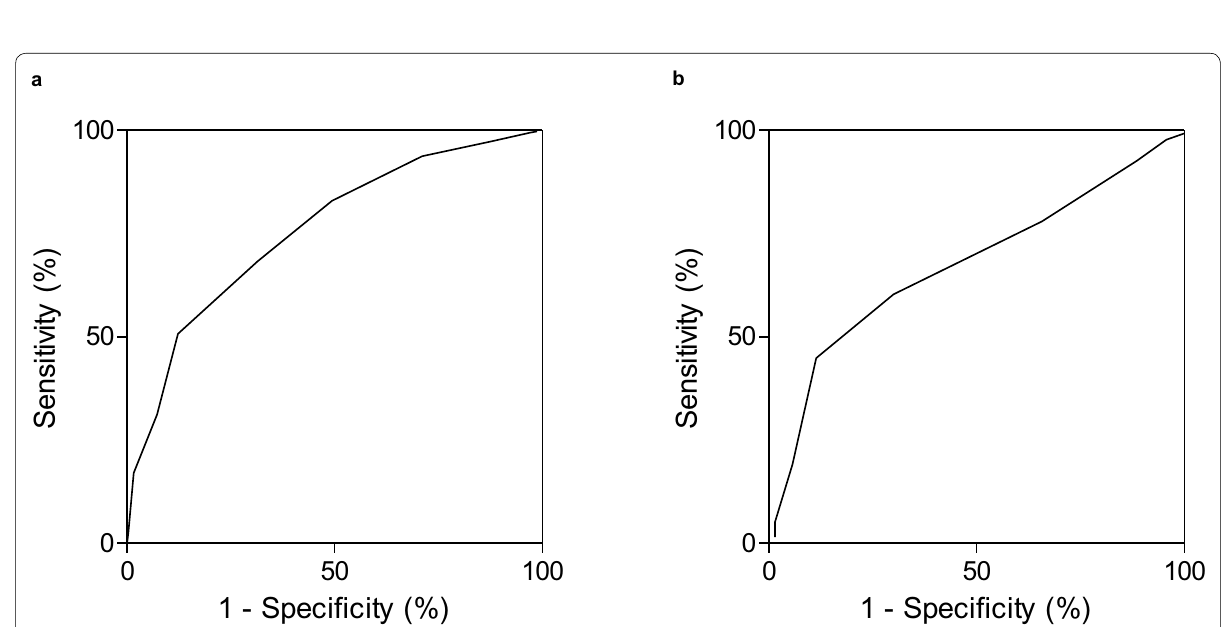
Fig. 2 ROC curves of CPIS for the diagnosis of VAP amongst patients with VA LRTI in the derivation ( a ) and validation ( b ) cohorts. A sensitivity analysis was performed for the accuracy of CPIS in diagnosing VAP amongst patients with VA LRTI and ROC curves were computerized in derivation and validation cohorts. CPIS Clinical pulmonary infection score, VAP Ventilator‑associated pneumonia, VAT Ventilator‑associated tracheobronchitis, VA LRTI Ventilator‑associated lower respiratory tract